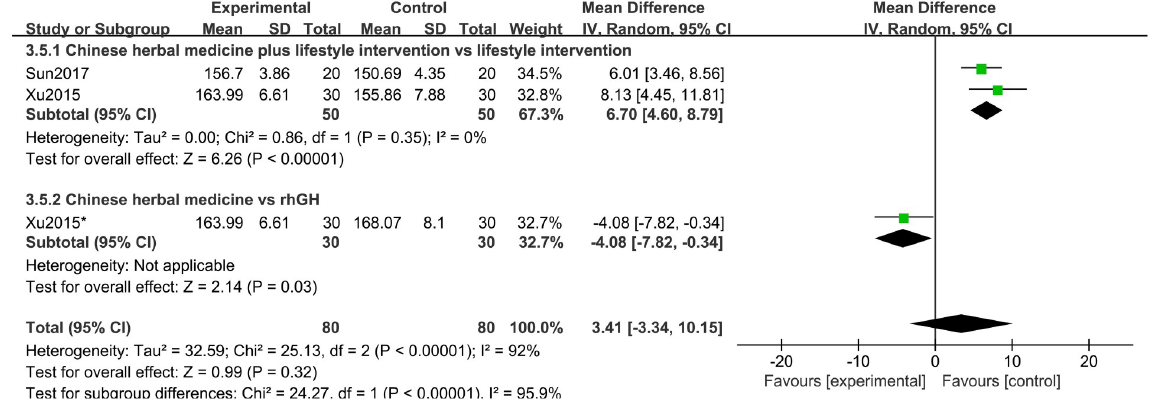
Fig 19. Subgroup analysis of PAH based on the